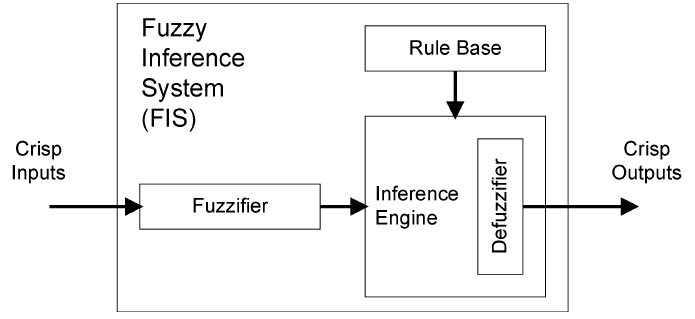
FIGURE 1 Fuzzy inference system (FIS) block